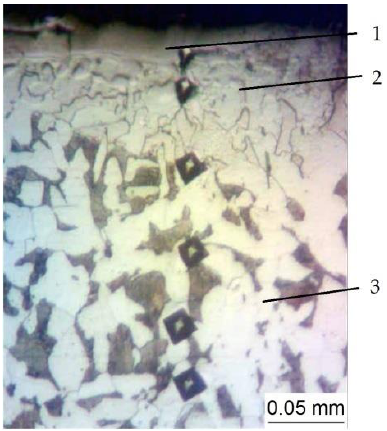
Figure 1. The microstructure of the steel C22 specimen surface layer after the ESA process with the use of the aluminum electrode-tool: 1 —” white layer ” , 2 — the diffusion zone, 3 — the base metal.